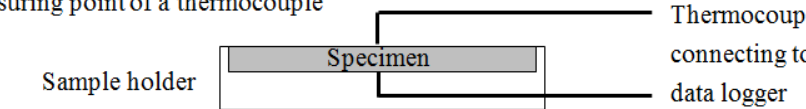
Figure 5. The schematic of setting up thermocouples.